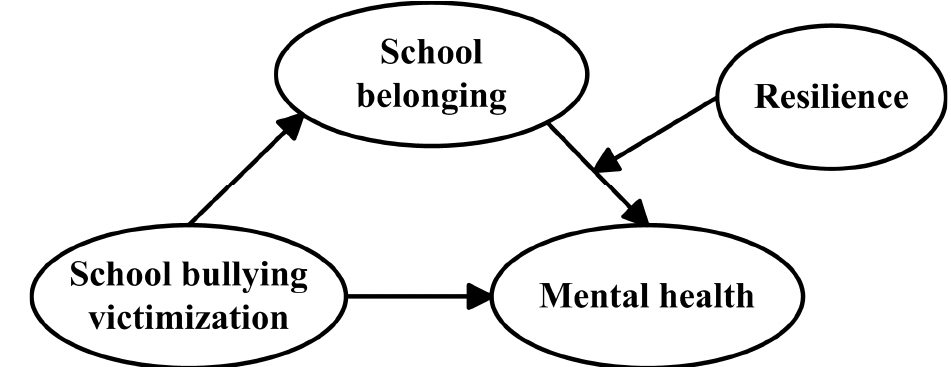
Figure 1. A conceptual diagram of the hypothesized relations in a moderated mediation model.